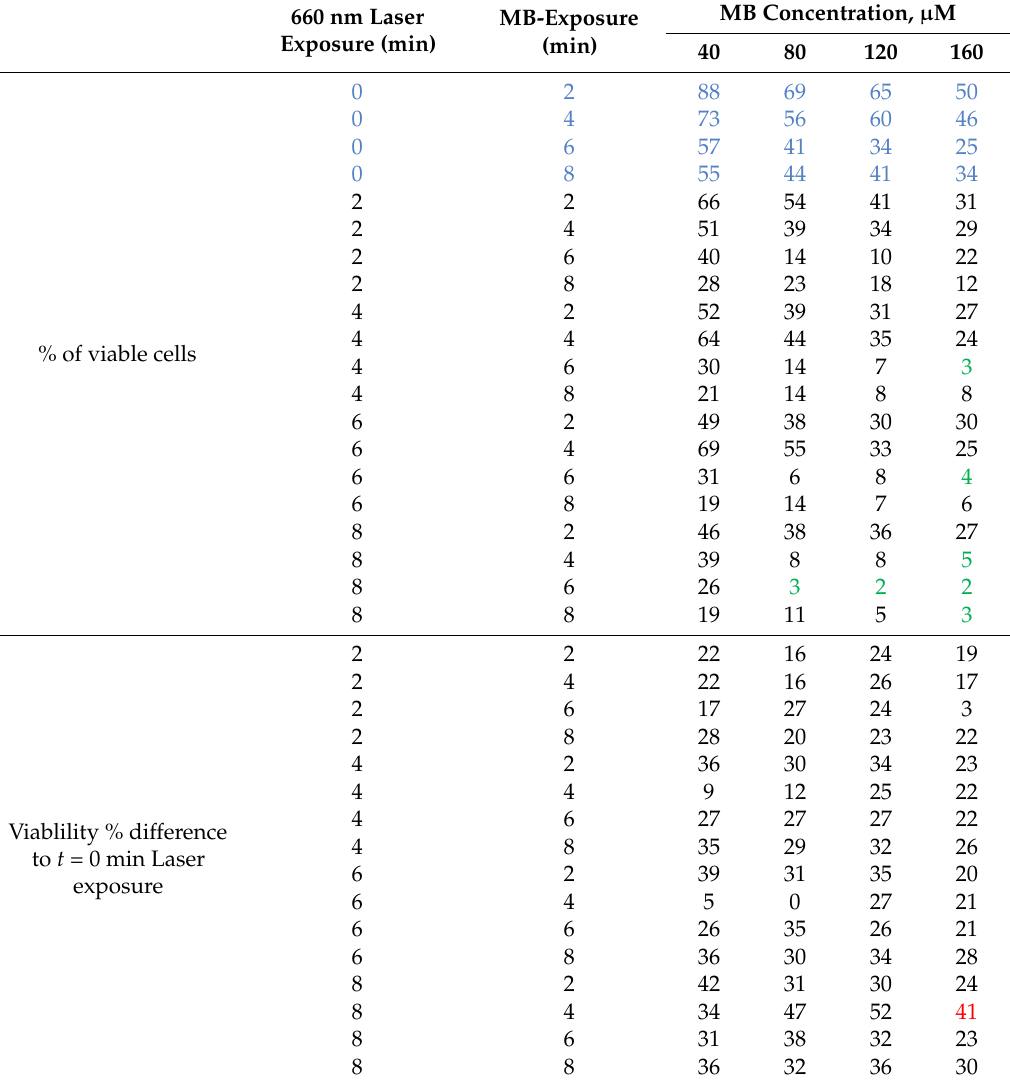
Table 2. Phototoxic effect on top of MB-toxicity 660 nm laser exposure after MB pretreatment at different concentrations and times on Detroit 562 cells. MB alone achieved up to 75% cell loss (written in blue). The treatment aim was to decrease the cell viability up to 95% cell loss, which was only achieved in combination of MB and 660 nm laser exposure. The combinations achieved this aim are written in green. The lower part of the table shows the differential effects of 660 nm laser exposure on top of the MB effect. The highest laser-specific effect, which was accompanied with at least 95% cell loss, is written in